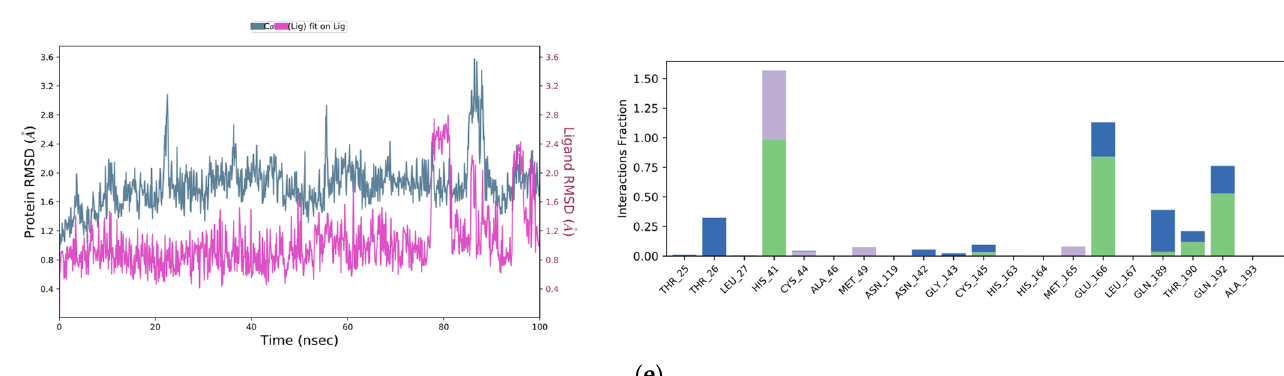
Figure 4. Five consensus top ranked compounds RMSD plots and protein ligand contacts histograms monitored throughout the MD simulations analysis. Green bar, H-bonds; blue bar, water mediated H-bonds; purple bar, hydrophobic. ( a ) Cmpd I. ( b ) Cmpd II. ( c ) Cmpd III. ( d ) Cmpd IV. ( e ) Cmpd V.